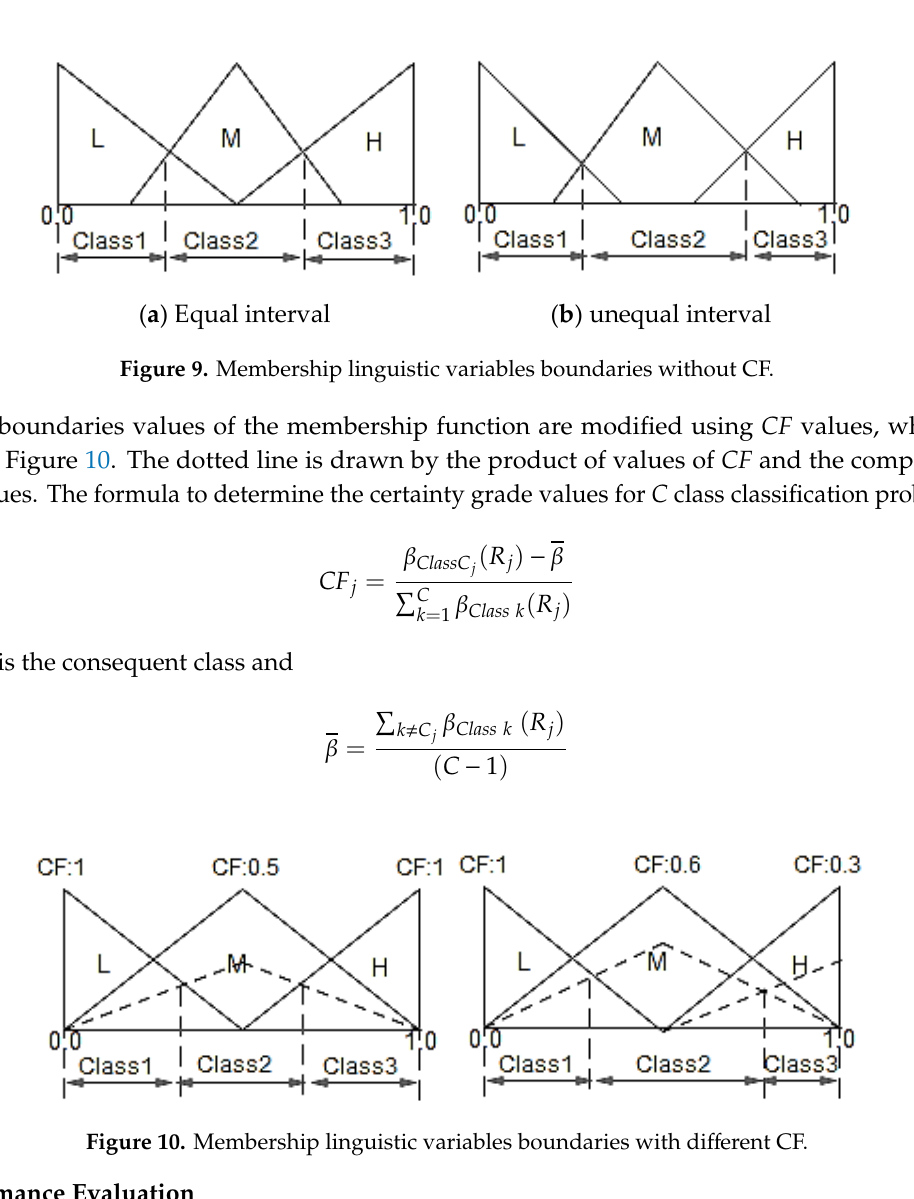
Figure 10. Membership linguistic variables boundaries with different CF. Table 9. PV panels classification test results.